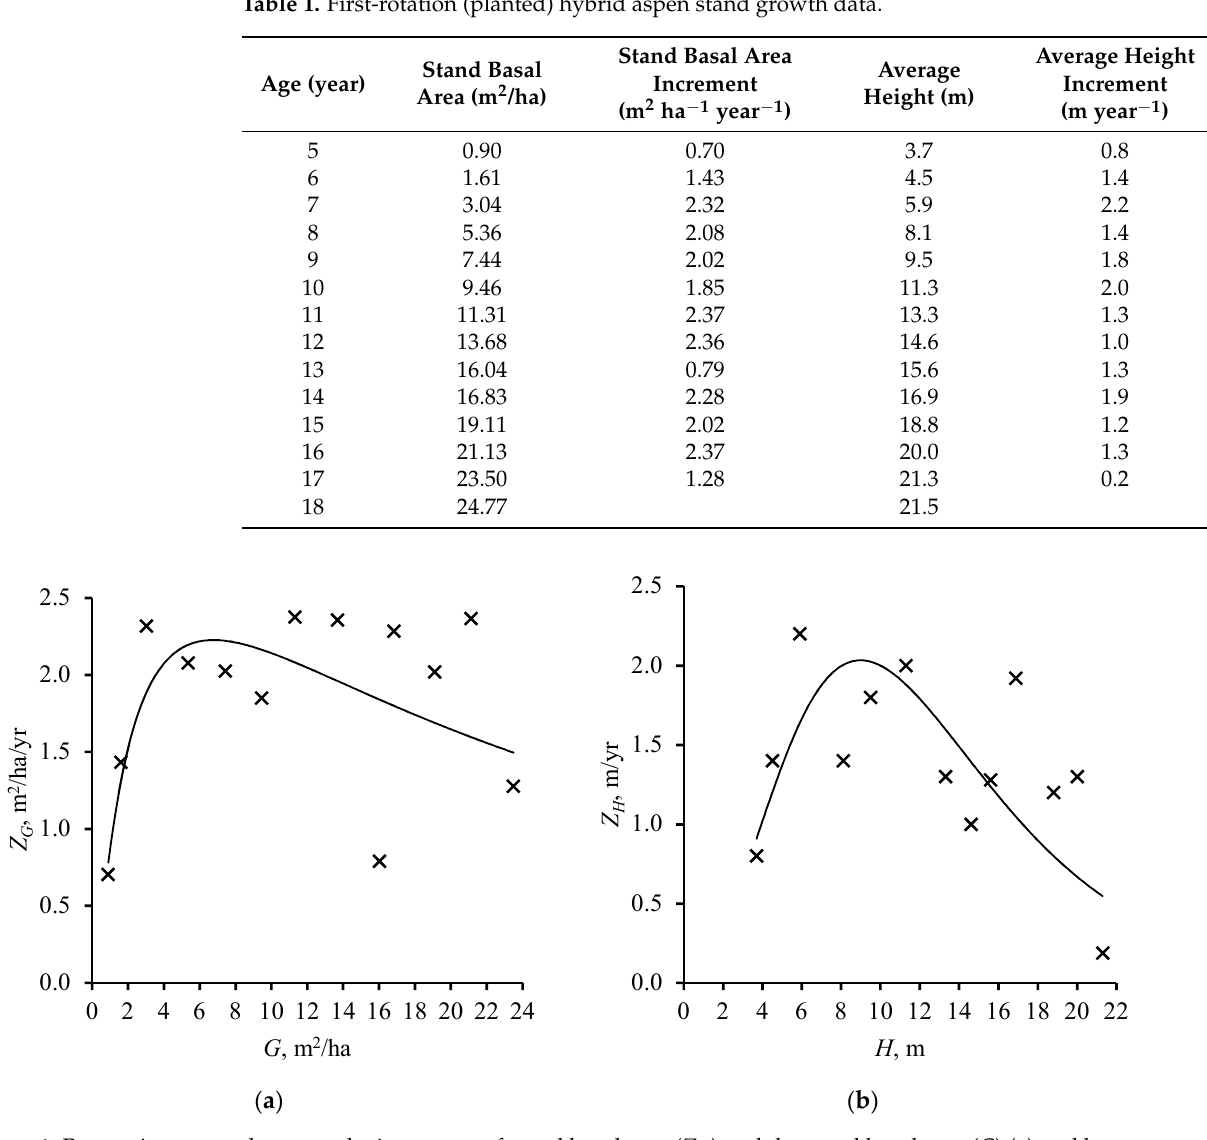
Figure 1. Regression curves between the increment of stand basal area ( Z G ) and the stand basal area ( G ) ( a ) and between the average height increment ( Z H ) and the height ( H ) ( b ). The parameter estimates of the regression models are presented in Table 2. Table 2. Parameter estimates for Equations (3)–(6).